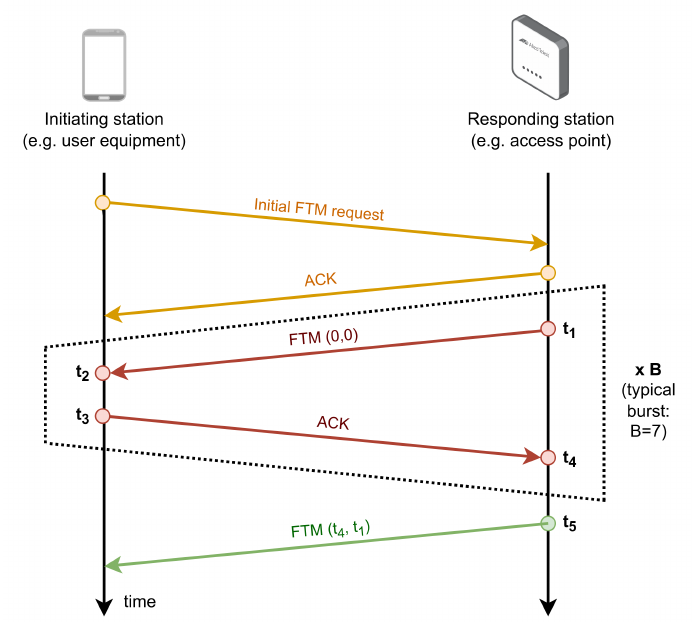
Figure 1. IEEE 802.11mc procedure for the RTT estimation. A typical burst for the Android API comprises seven RTT